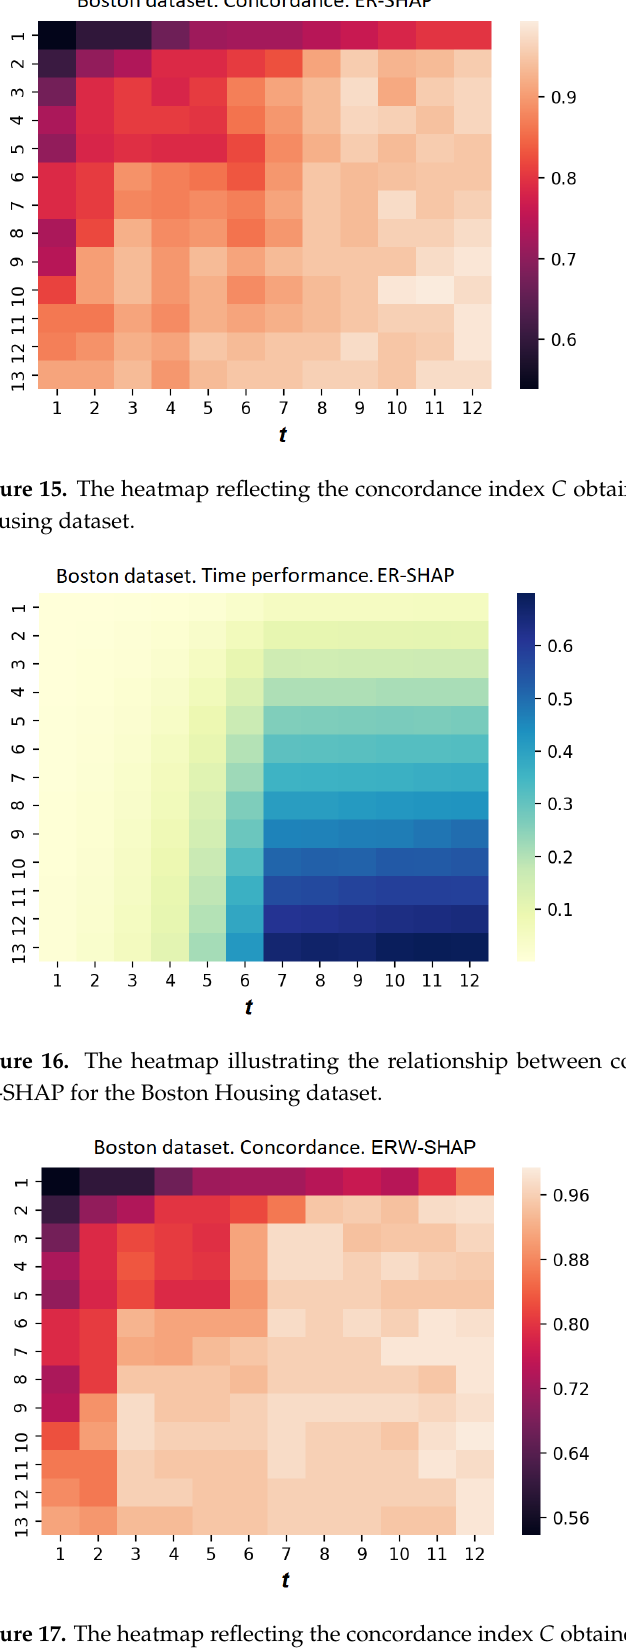
Figure 17. The heatmap reflecting the concordance index C obtained by ERW-SHAP for the Boston Housing